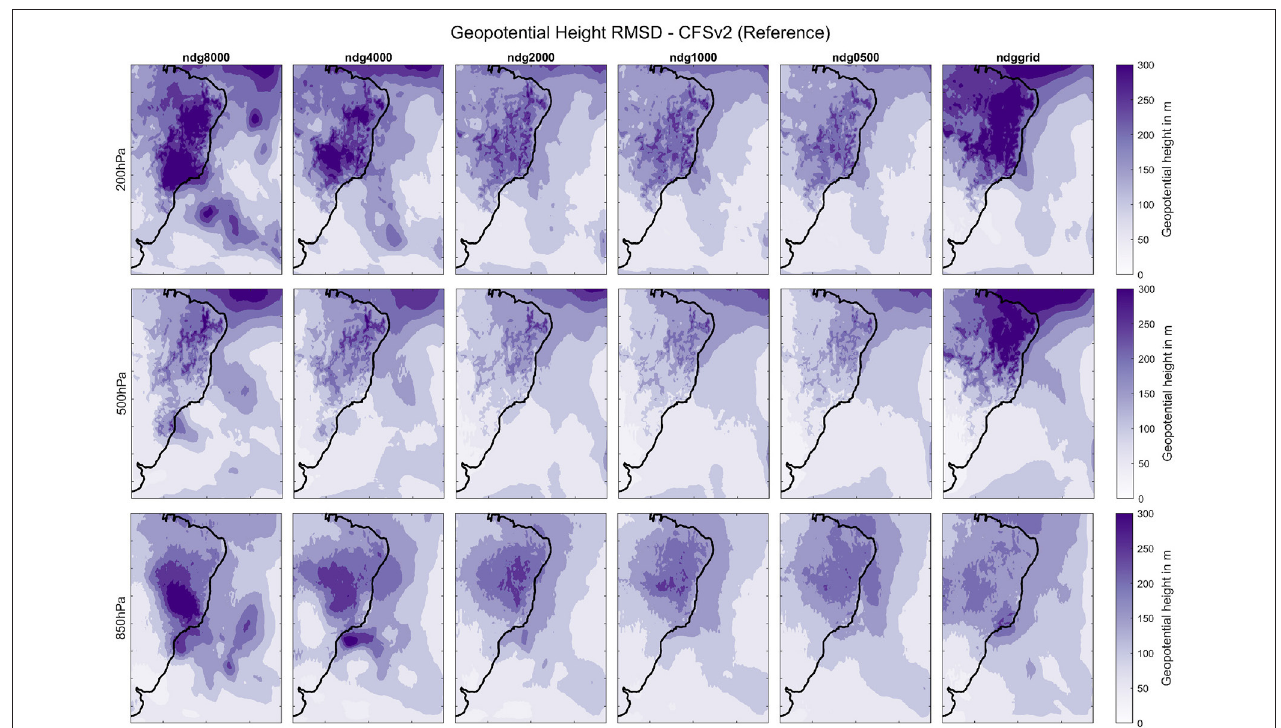
FIGURE 6 | RMSD of geopotential height values during the SACZ event. Maps of all numerical experiments (columns) for upper levels (200 hPa, top row), middle levels (500 hPa, middle row) and lower levels (850 hPa, bottom row) are shown.